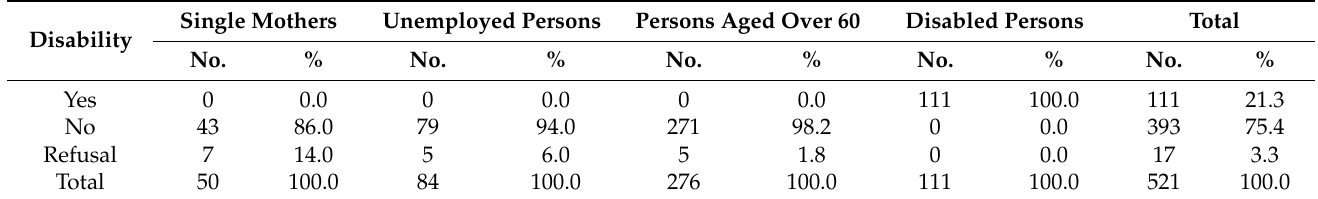
Table 5. Characteristics of the survey population by disability and social status ( n = 521).